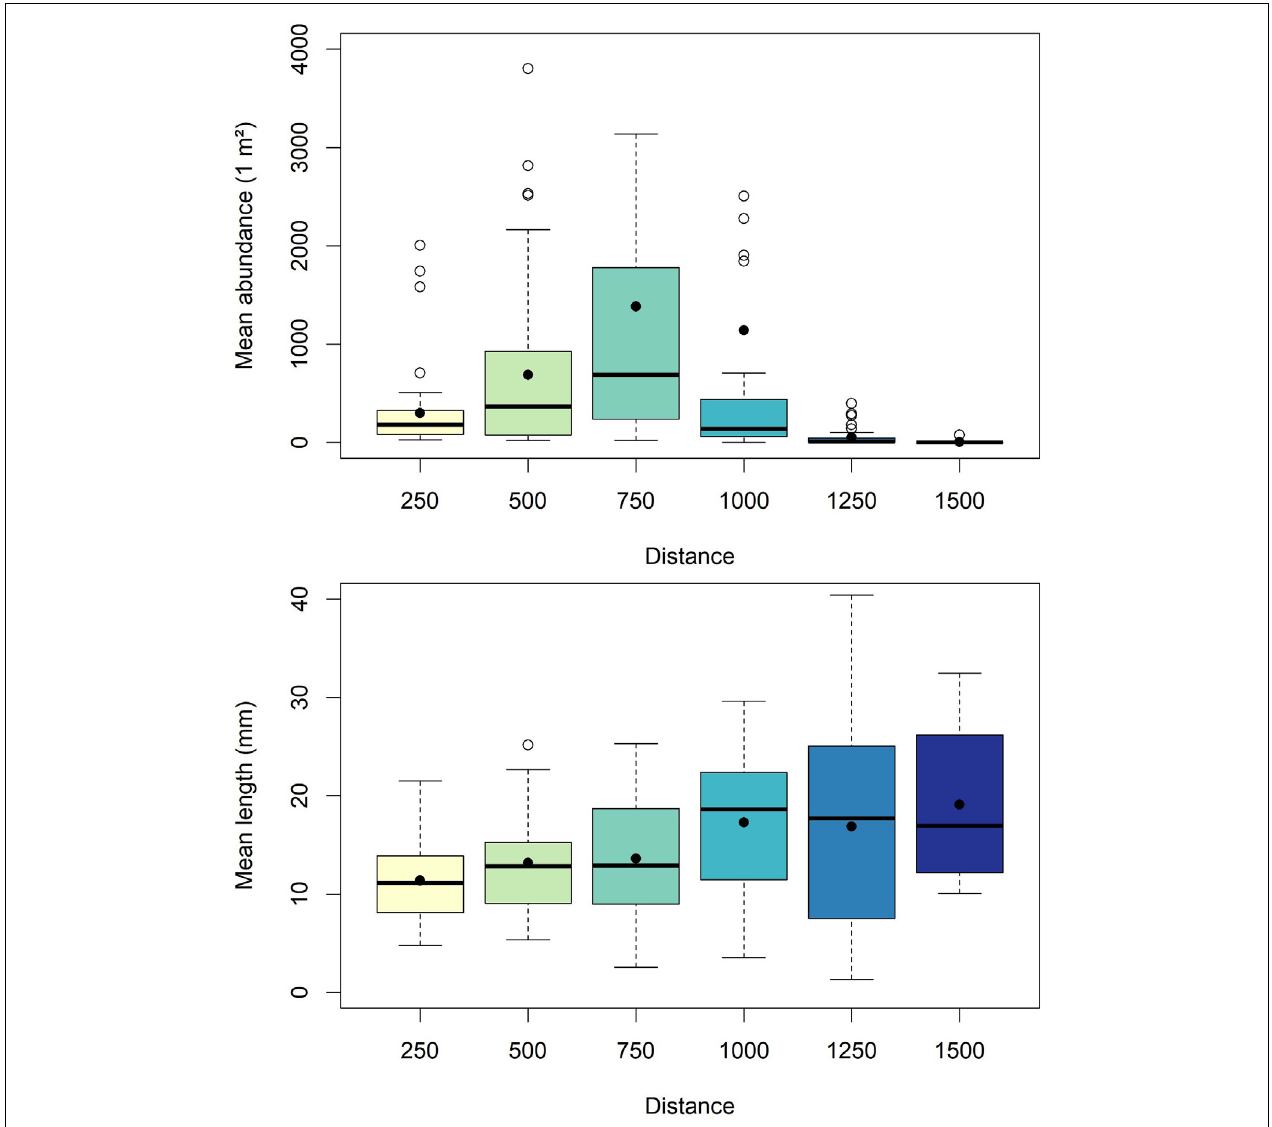
FIGURE 4 | Mean abundance (individuals per m 2 ) and length (mm) per sampling distance (m).